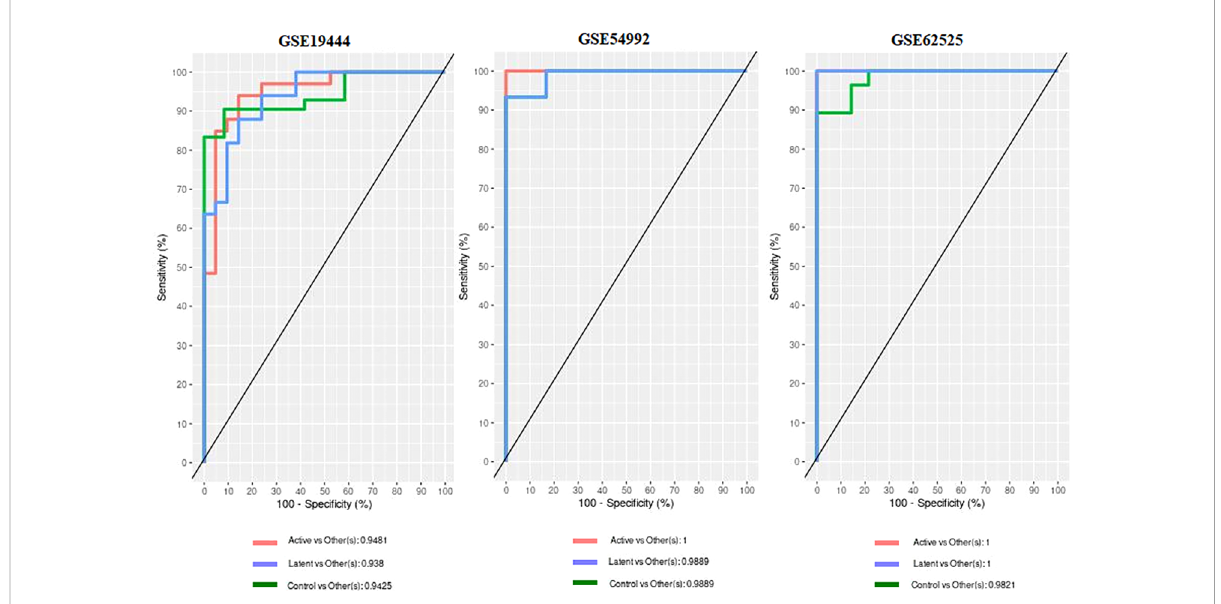
FIGURE 4 Receiver operating characteristic (ROC) and Area under curve (AUC) from the PLS-DA on the 113 DEGs